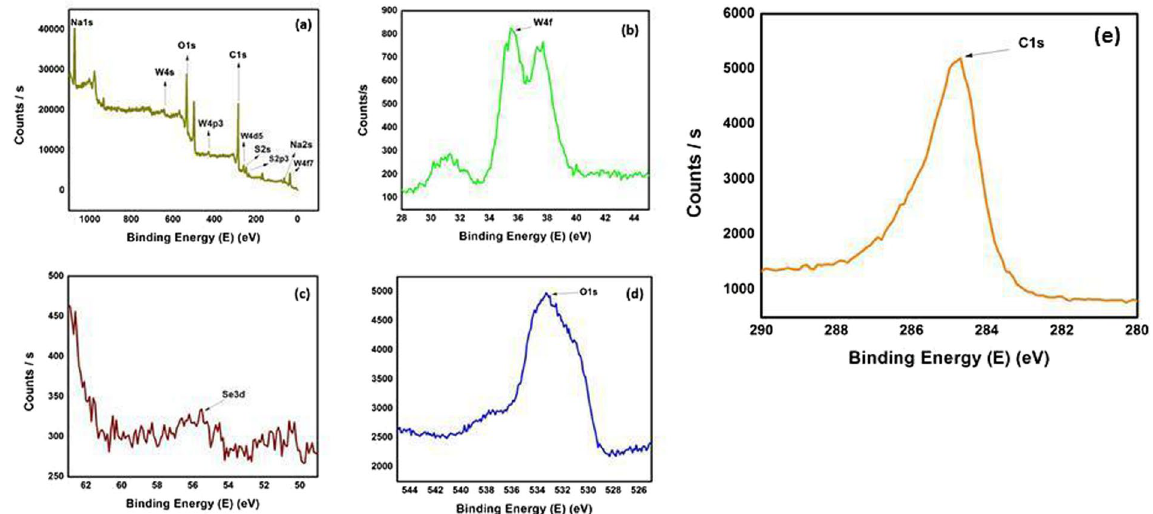
Figure 6. XPS spectra of the WSe 2 -graphene nanocomposite: ( a ) survey scan spectra ( b ) W4f ( c ) Se3d ( d ) O1s and ( e ) C1s.